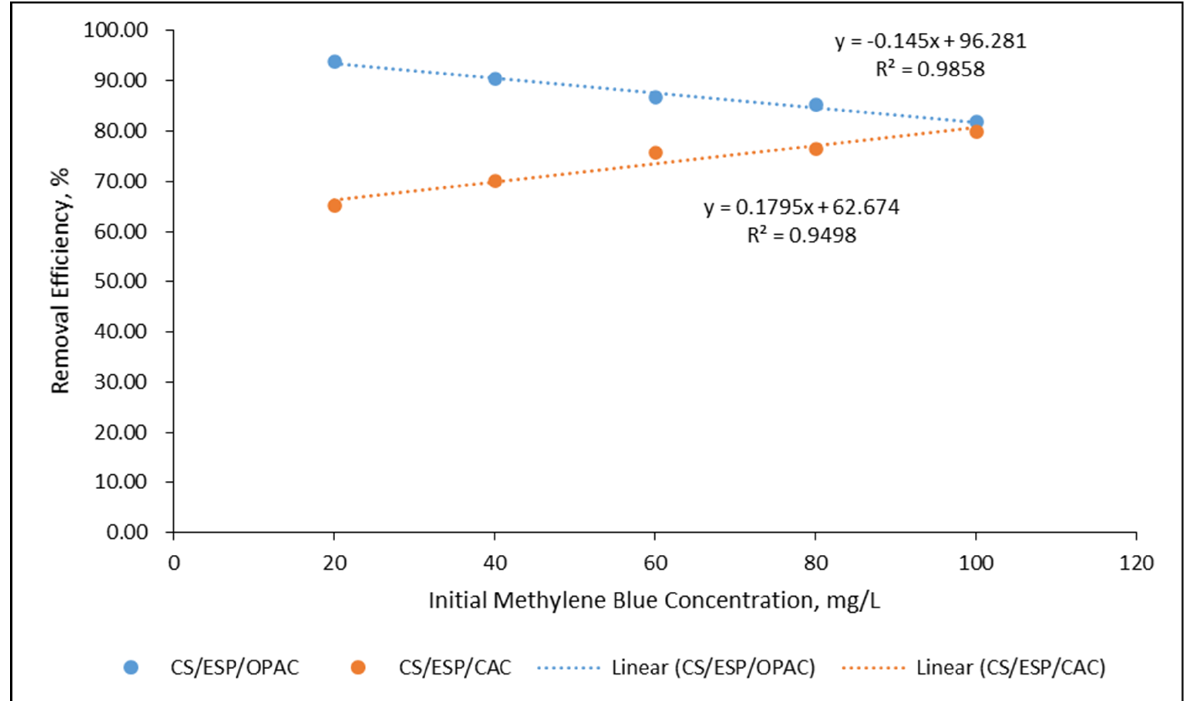
Figure 5. Effect of initial methylene blue dye concentrations on the removal efficiency of methylene blue dye by CS/ESP/OPAC and CS/ESP/CAC films.